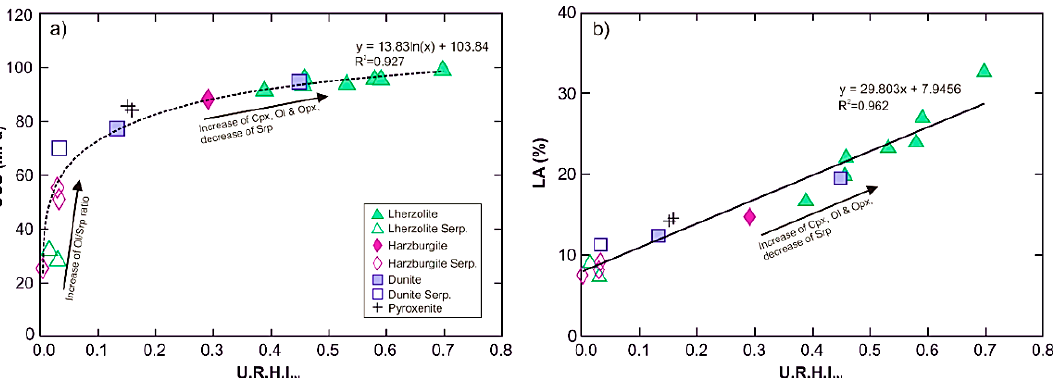
Figure 7. Correlation diagrams of ( a ) UCS (MPa) vs. U.R.C.I. N and ( b ) La (%) vs. U.R.C.I. N . The increase in both UCS (MPa) and LA (%) is correlated to increasing primary mineral/serpentine (Srp) ratios. Primary minerals include orthopyroxene (Opx), clinopyroxene (Cpx) and olivine (Ol).